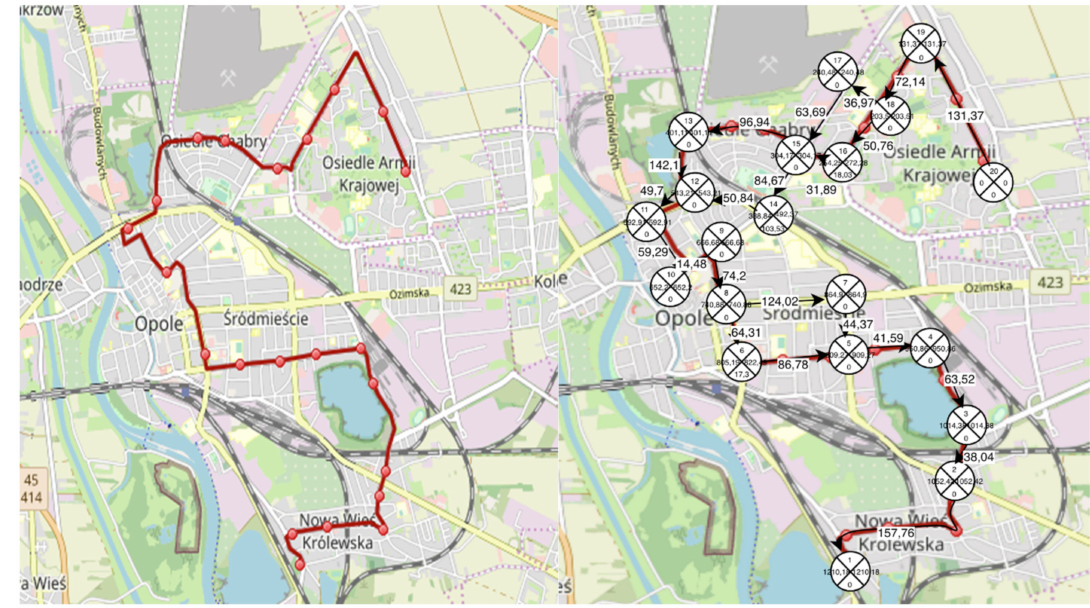
Figure 8. Modelled route of the current bus line no.